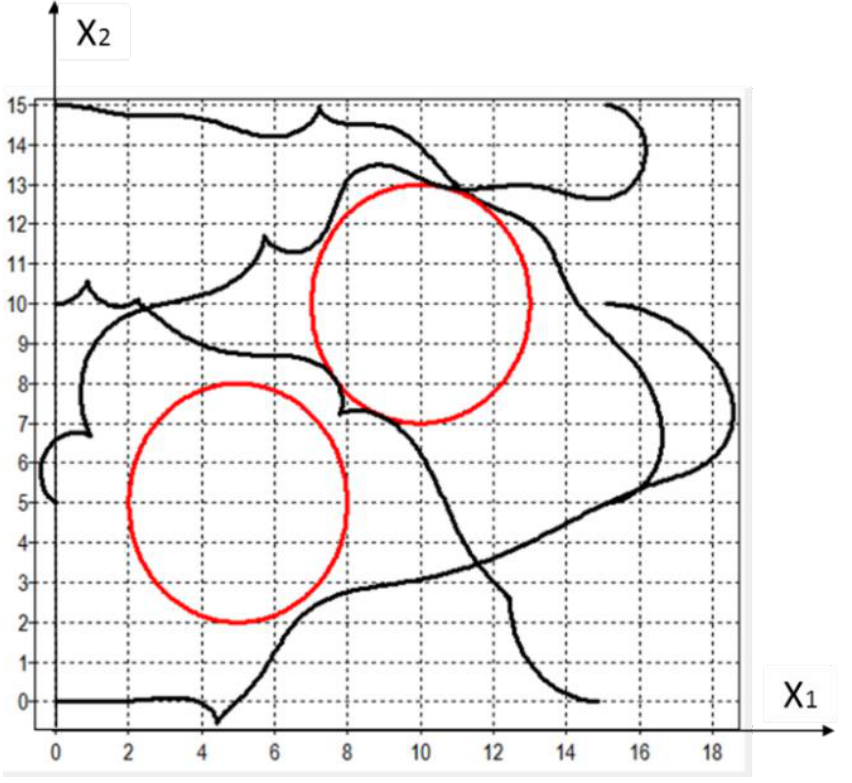
Figure 2. Solution obtained using a direct approach with PSO, 2 . 81 J = . Table 2. The results of experiments: synthesized control. N о .